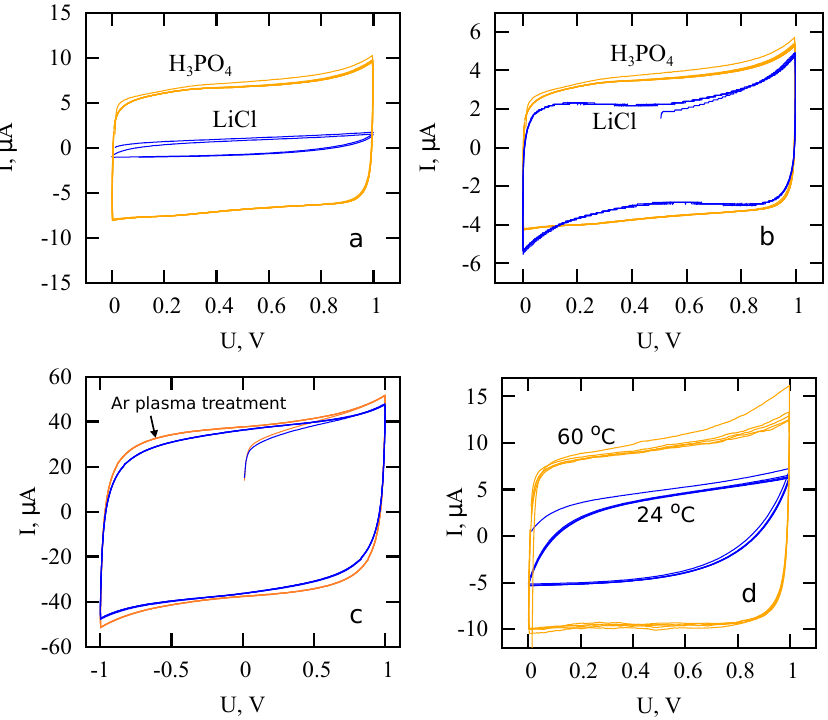
Figure 2. Cyclic voltammograms of planar micro-supercapacitor with solid electrolyte PVA + H 3 PO 4 for scanning rates 50 mV/s ( a ) and 25 mV/s ( b ) as well as for the plasma treated sample ( c ) and curves measured at two different temperatures ( d ).